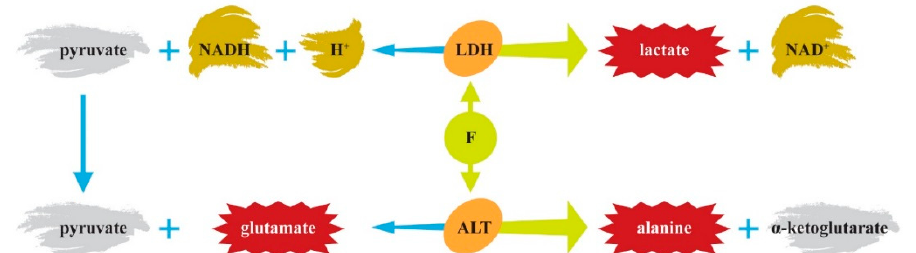
Figure 1. Patients with autism spectrum disorder (ASD) have increased levels of blood lactate, alanine, and glutamate. LDH—lactate dehydrogenase; ALT—alanine transaminase.